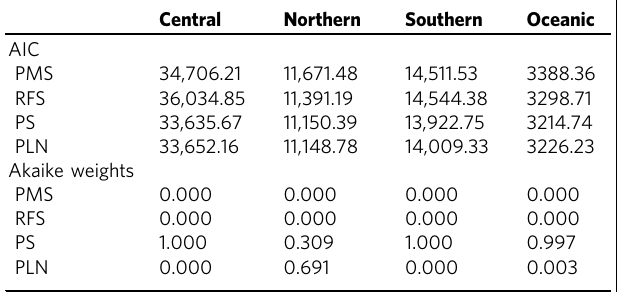
Models were compared based on their "composite likelihood ” suggested by Alonso and McKane 70